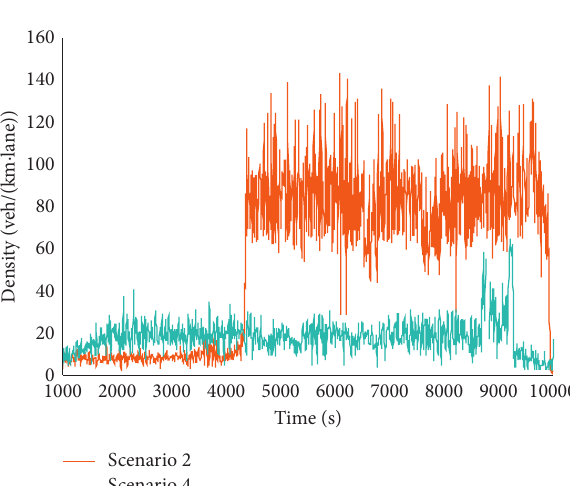
Figure 4: Scenario 2 simulation result diagram.